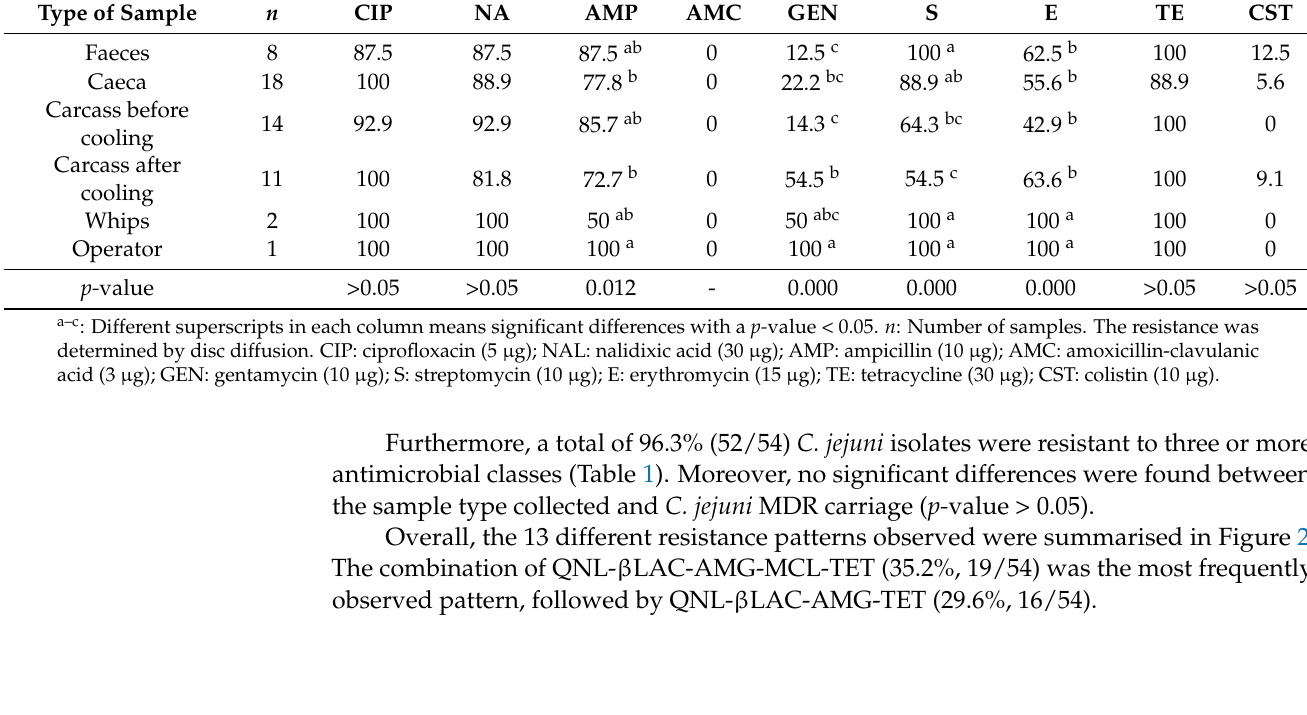
Table 2. C. jejuni antibiotic resistance rates according to the antibiotic and the type of sample collected. Type of